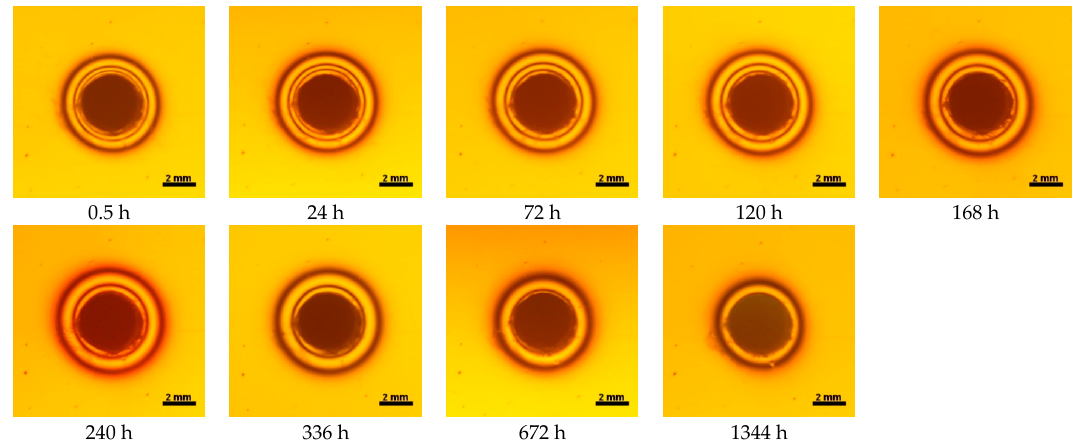
Figure 11. Isochromes in epoxy plate around Tetric EvoCeram restoration before and after water storage 0.5–1344 h.